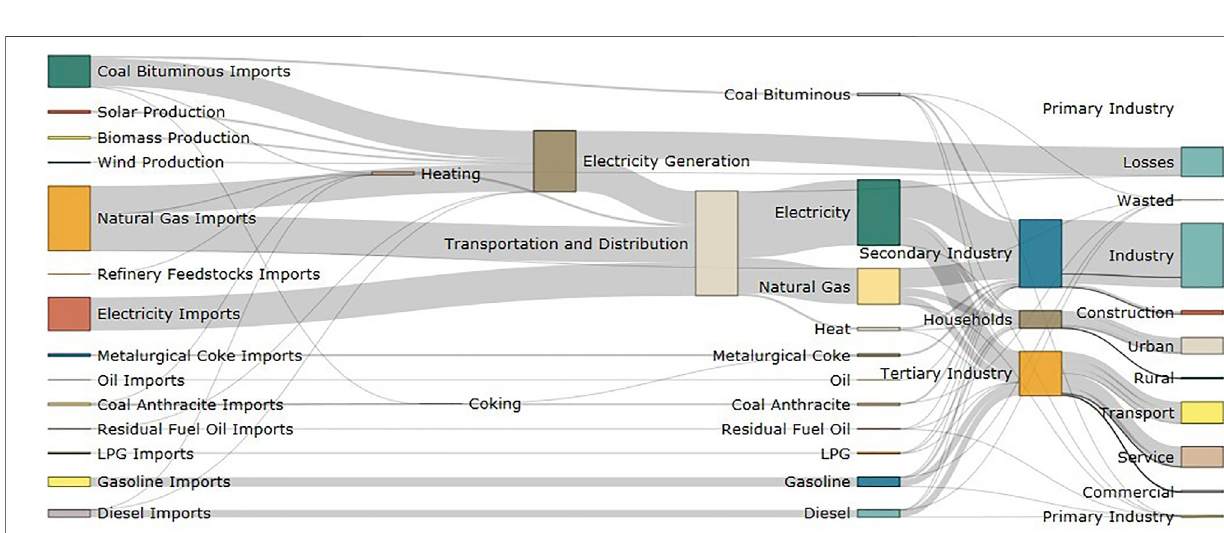
FIGURE 11 | Energy fl ow in 2050 under the ETD